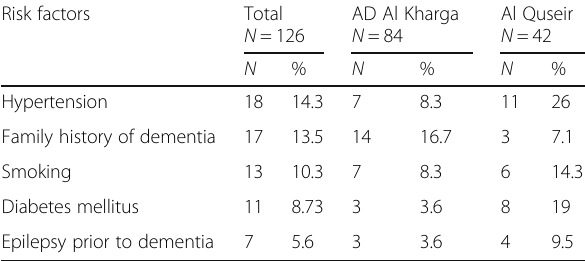
Table 4 Prevalence of possible risk factors for Alzheimer ’ s Dementia in Upper Egypt, Desert area, in order of Frequency Risk factors